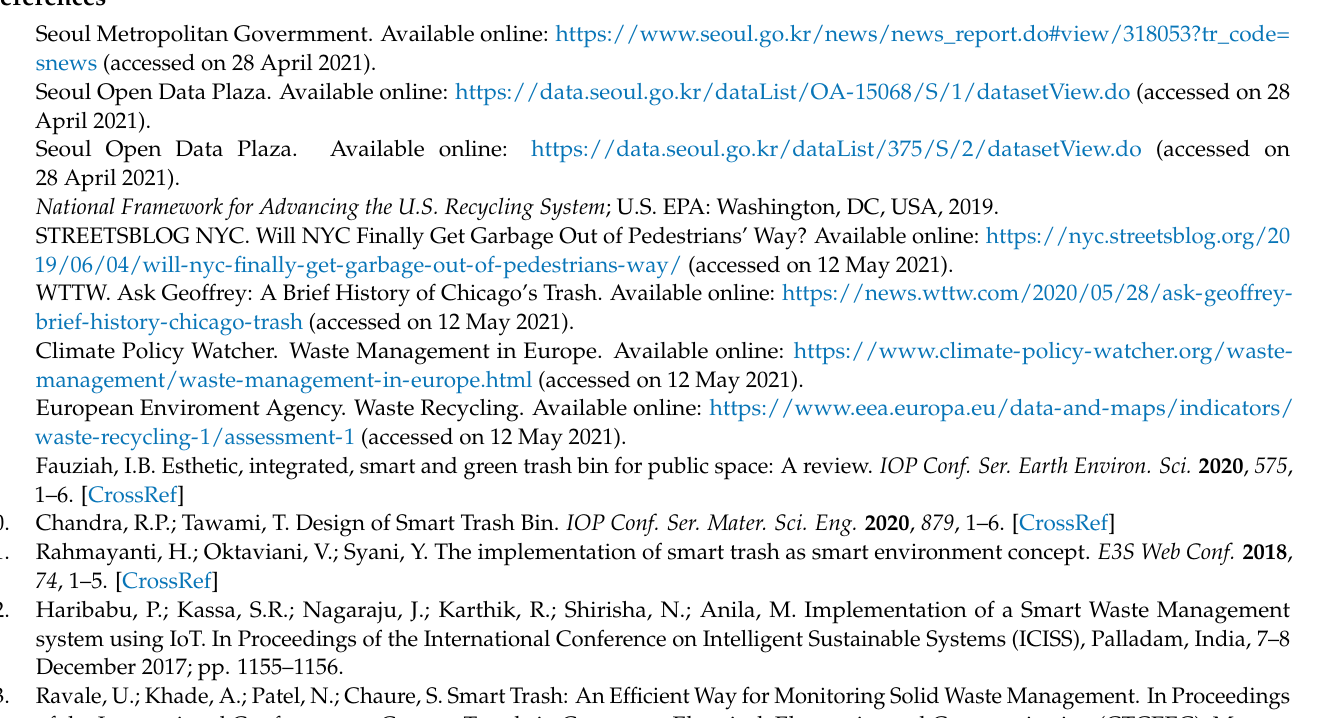
Figure A4. Smart Trash Bin Main Process and Result using Python pseudocode.